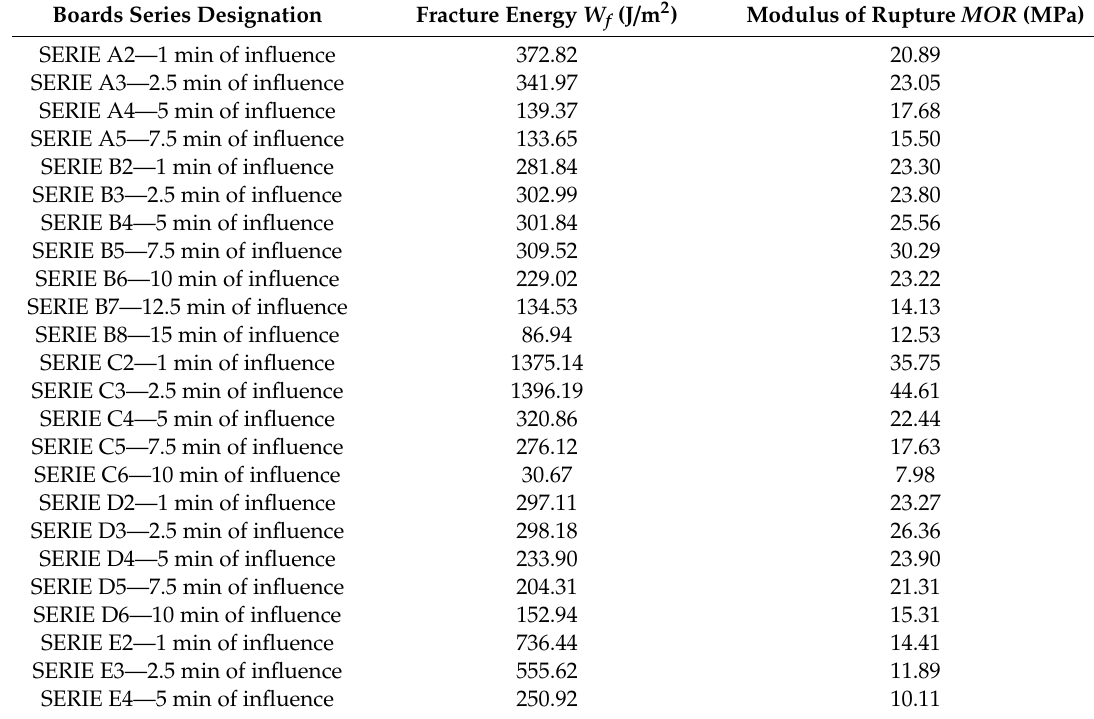
Table 2. Aggregate summary of averaged values of fracture energy W f and modulus of rupture MOR for panels, under the influence of high temperature 400 ◦ C from 1 to 15 min